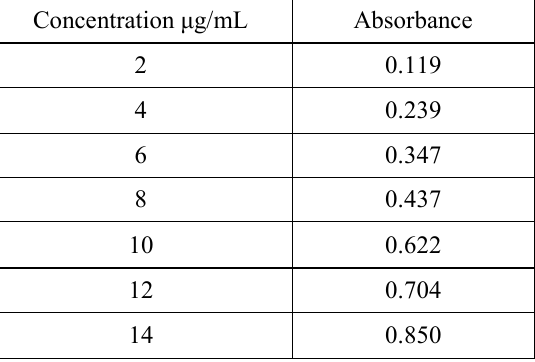
Table 1. Calibration Curve Parameter.